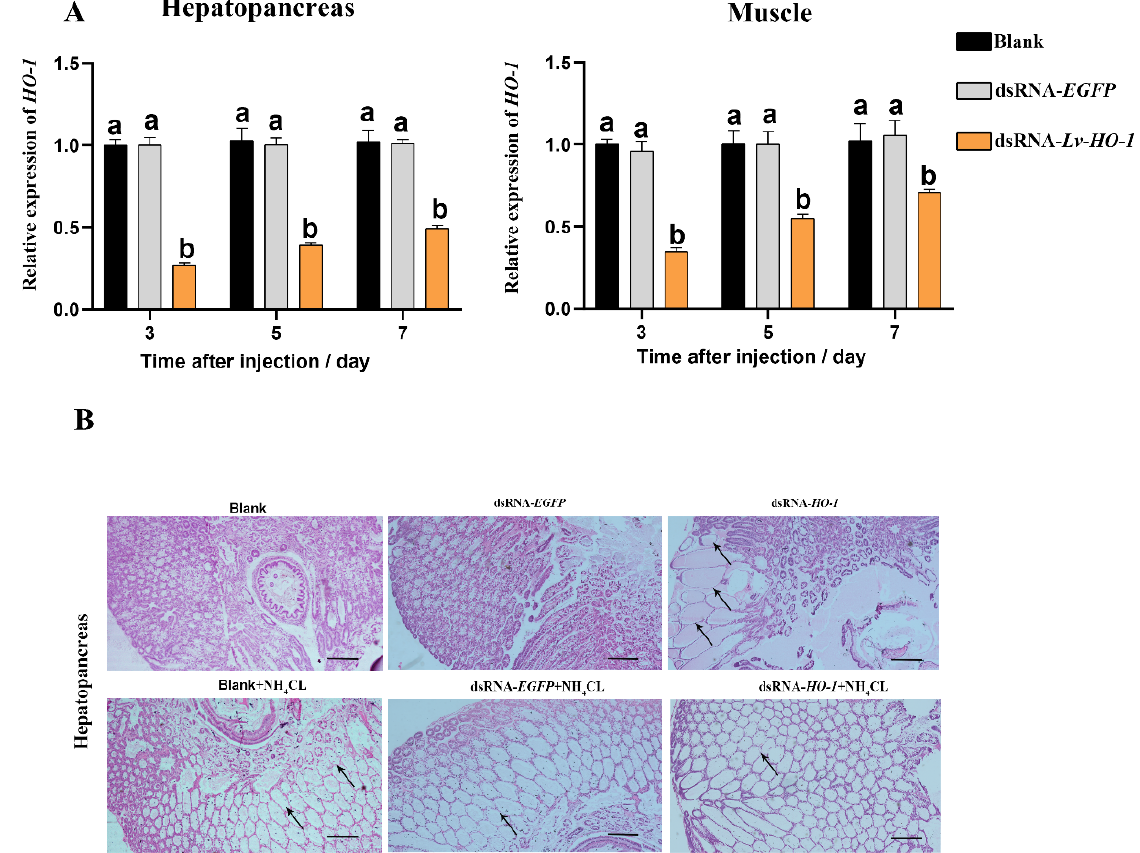
Figure 4. ( A ) Levels of Lv-HO-1 mRNA in hepatopancreas and muscle after RNAi injection. Significant difference ( p < 0.05) in the dsRNA- Lv-HO-1 group compared with the Blank or PBS group is denoted by different letters. ( B ) Histological examination of hepatopancreas after RNAi. The sections were stained with H&E (50× magnification, Scale plate: 20 μm). Arrows indicate thinning and dilatation of the hepatic tubule wall.